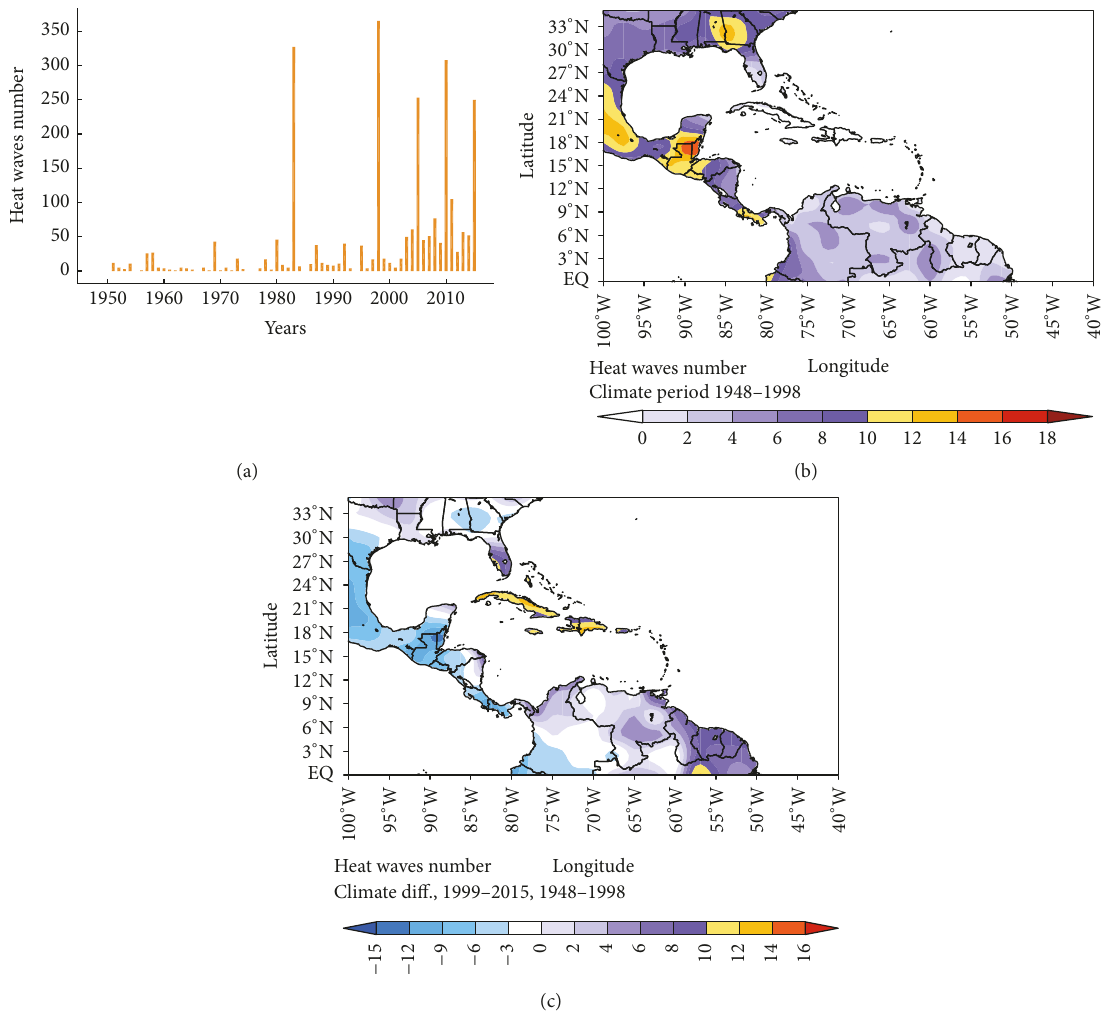
Figure 5: (a) Annual HWs number accumulated across the IAR for the period 1948–2015. (b) Heat waves number in the LRS in the first climate period 1948–1998. (c) Heat waves number change in the LRS between the climate periods 1999–2015 and 1948–1998.